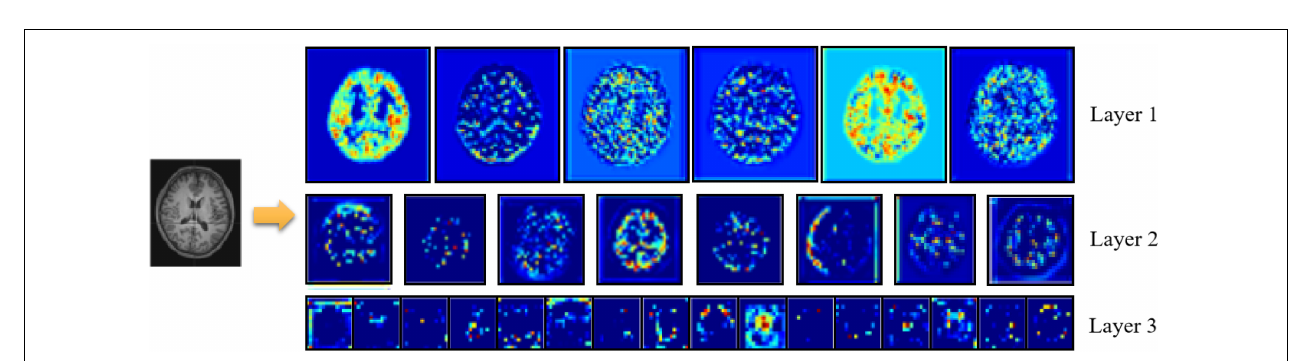
FIGURE 6 | Proposed 3D-ResNet structure.